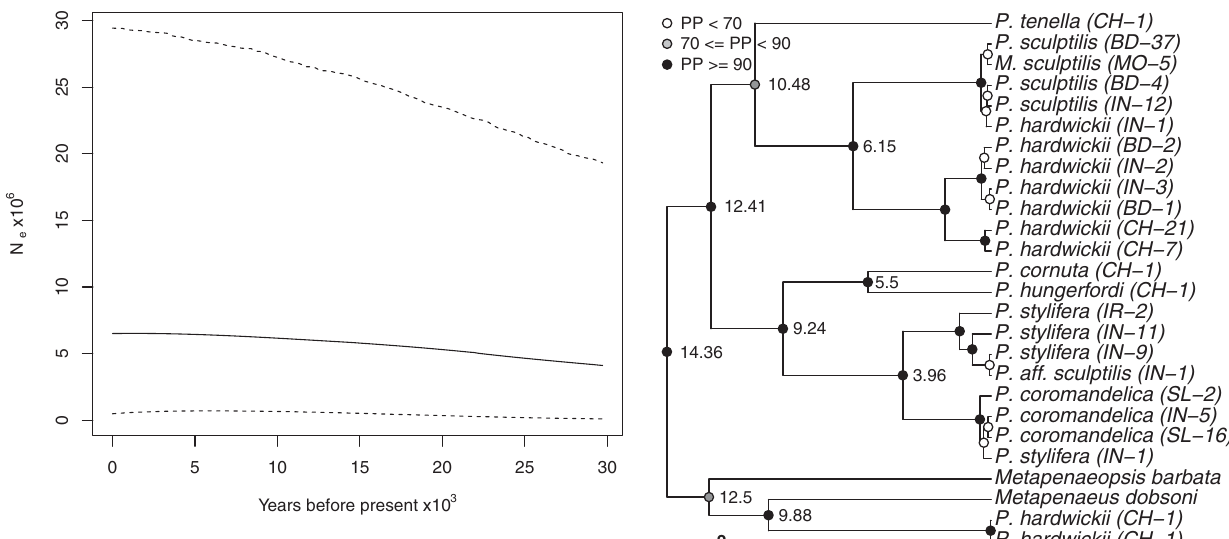
Fig. 4. Bayesian Skyline Plot of Parapenaeopsis sculptilis in Bangladesh. The past population dynamics in the plot was estimated from 40 (589 bps) sequences of CO1 barcode. The 95% con fi dence intervals were shown using dotted lines. Effective population size (N e (cid:3) 10 6 ) per generation is traced back in time from the present to the past.